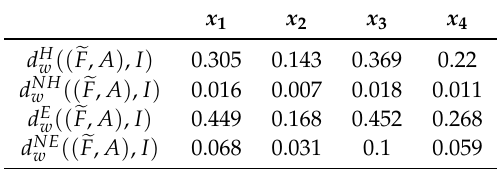
Table 3. Weighted distance measure of ( (cid:101) F , A ) and I using Definition 13.